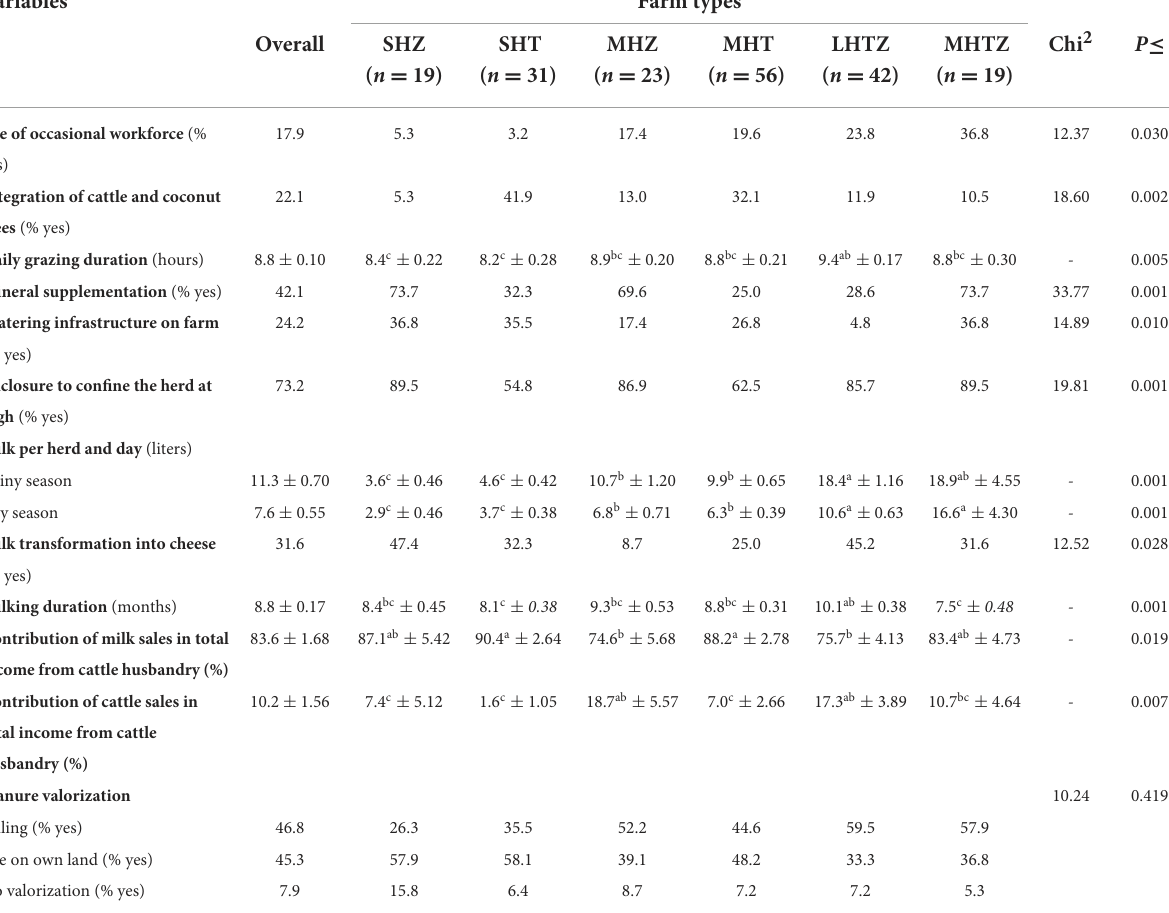
TABLE 7 Cattle herd management across farm types in peri-urban areas of south Benin; data depict either frequencies (%) or means ± standard error. Variables Farm